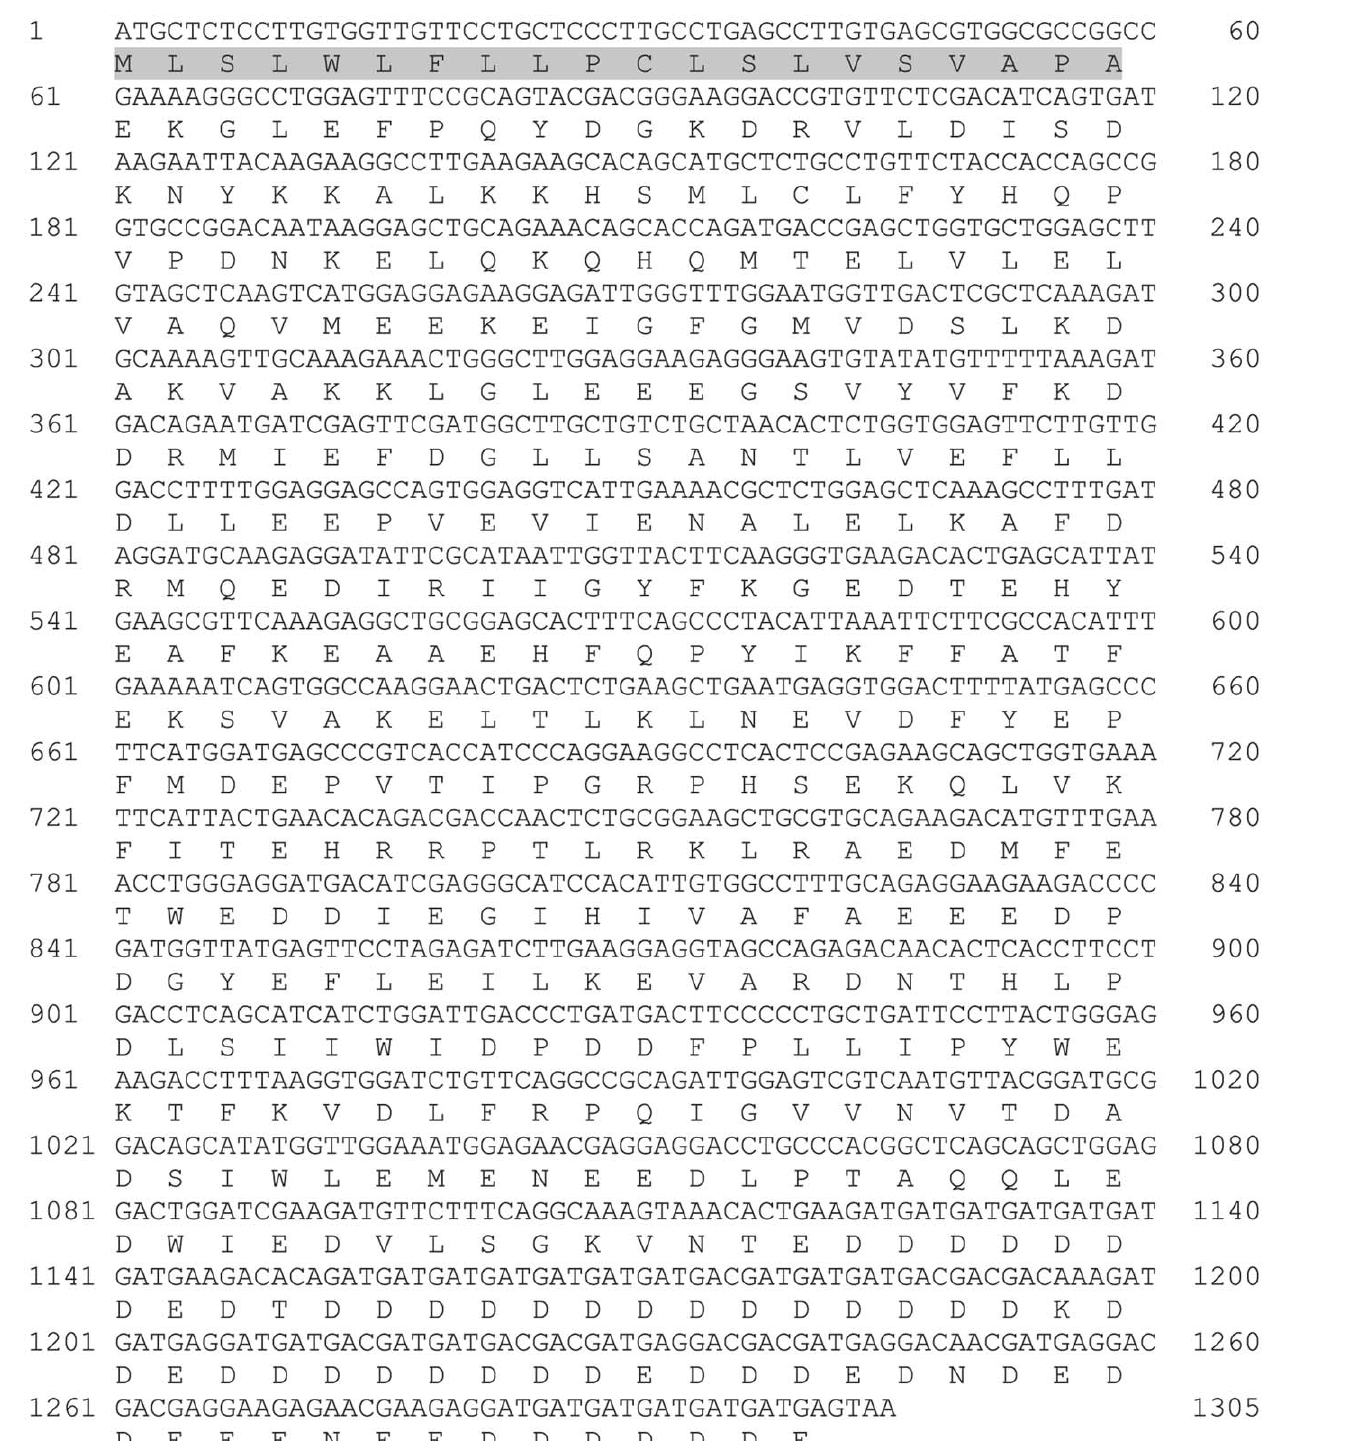
Figure 1. Nucleotide and deduced amino acid sequence of the coding region of FCSQ cDNA. Sequences were reconstructed from overlapping sequences of PCR amplified fragments. Primer sequences were removed prior to alignment. The putative SR targeting sequence is shaded. doi:10.1371/journal.pone.0050801.g001 isoforms and expression patterns of CSQ in F. heteroclitus skeletal and cardiac muscles and to characterize the functions of these isoforms in this eurythermal teleost.